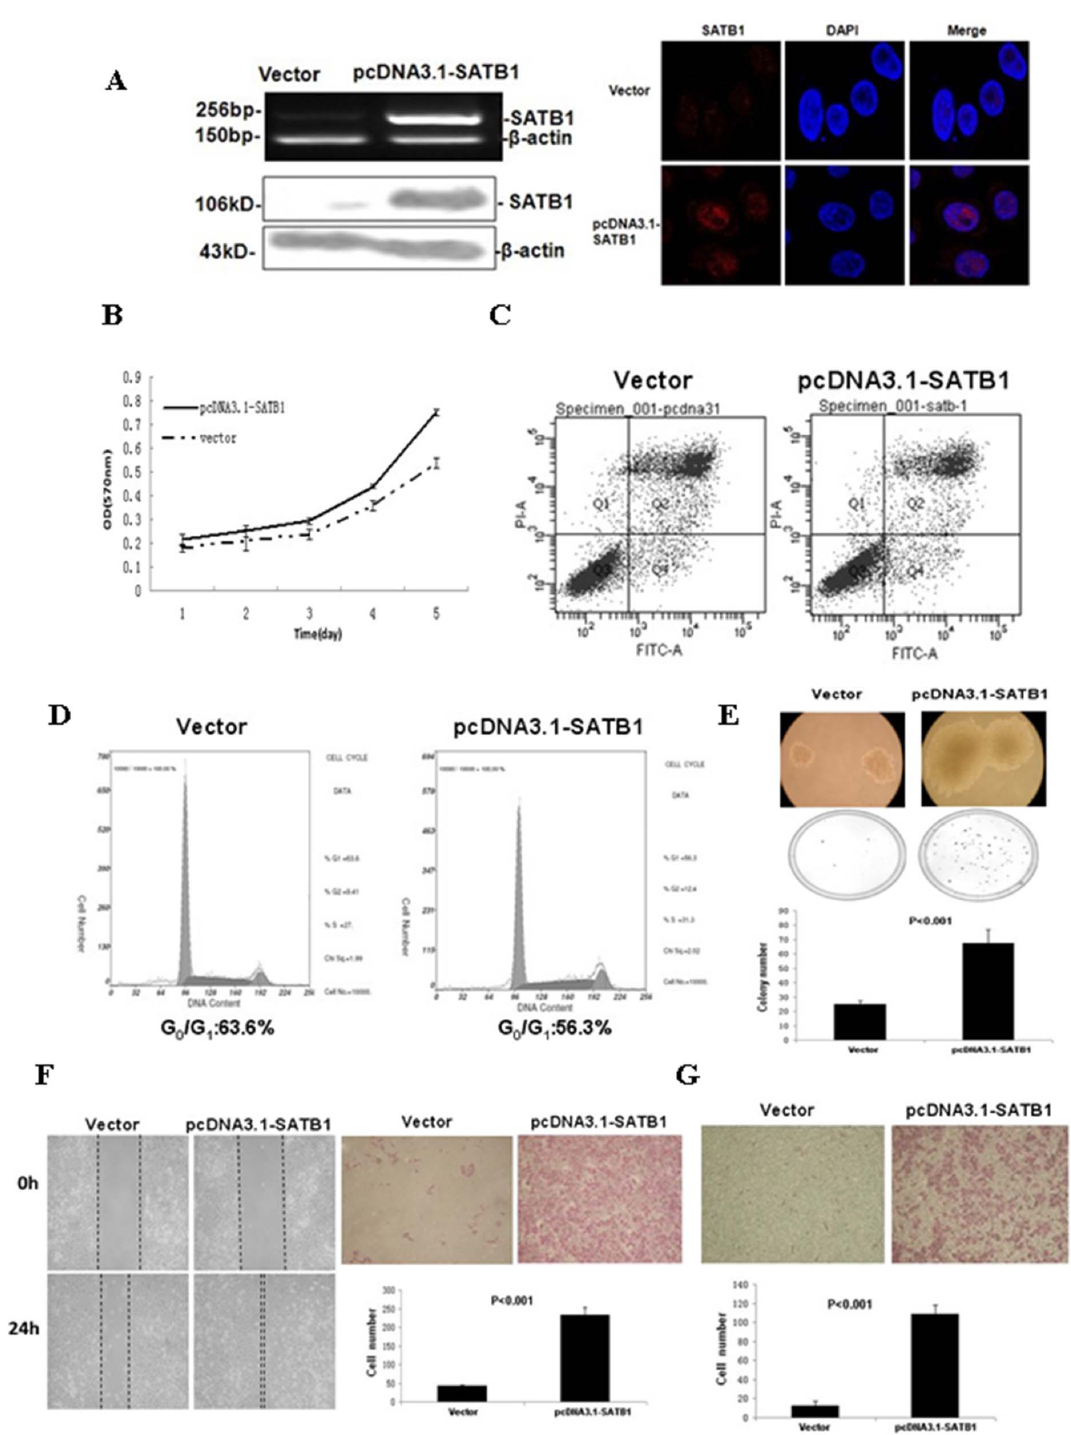
Figure 4. In SW480 cell lines, overexpression of SATB1 promotes cell proliferation, colony formation, migration, and invasion in vitro. (A) SW480 cells were transfected with the pcDNA3.1-SATB1 expression vector or empty vector. Upregulation of SATB1 mRNA and protein expression was verified by RT-PCR (top left panel), western blot (bottom left panel), and immunofluorescence (right panel). b -actin was used to ensure equal loading. (B) Cell proliferation of empty vector control and pcDNA3.1-SATB1 cells was determined by MTT assay. (C) Apoptosis of empty vector control and pcDNA3.1-SATB1 cells was determined by flow cytometry analysis of PI and Annexin V staining. (D) Flow cytometry analysis of cell cycle in empty vector control and pcDNA3.1-SATB1 cells. (E) Soft agar colony formation of empty vector control and pcDNA3.1-SATB1 cells after 3 weeks. (F) Migration of empty vector control and pcDNA3.1-SATB1 cells was determined by wound healing assay (left panel) and transwell migration assay (right panel). *p , 0.001, number of migrated cells compared to controls. (G) Cell invasion of empty vector control and pcDNA3.1-SATB1 cells was determined by Matrigel transwell invasion assay (*p , 0.001).